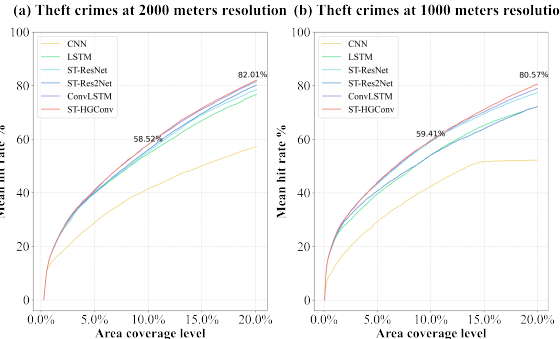
Figure 5. Trend of mean hit rate at different coverage